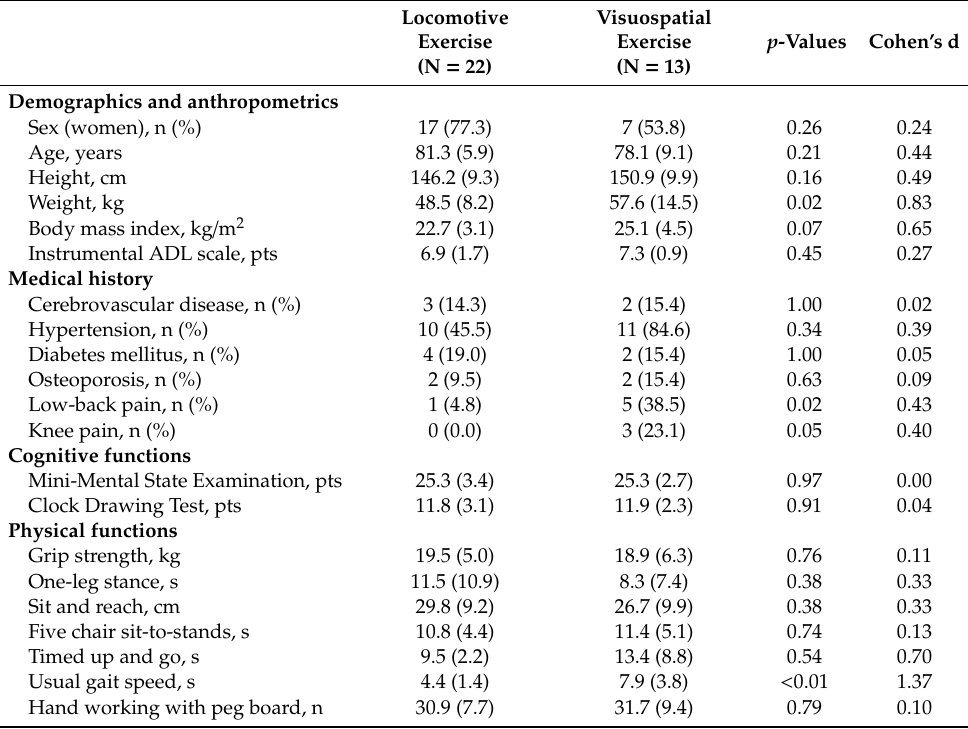
Table 1. Characteristics of the participants.